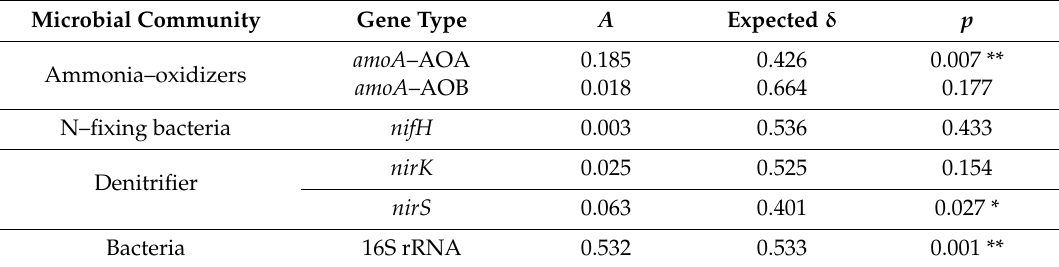
Table 4. Multi-Response Permutation Procedure (MRPP) results for the effects of agroecosystems on Microbial